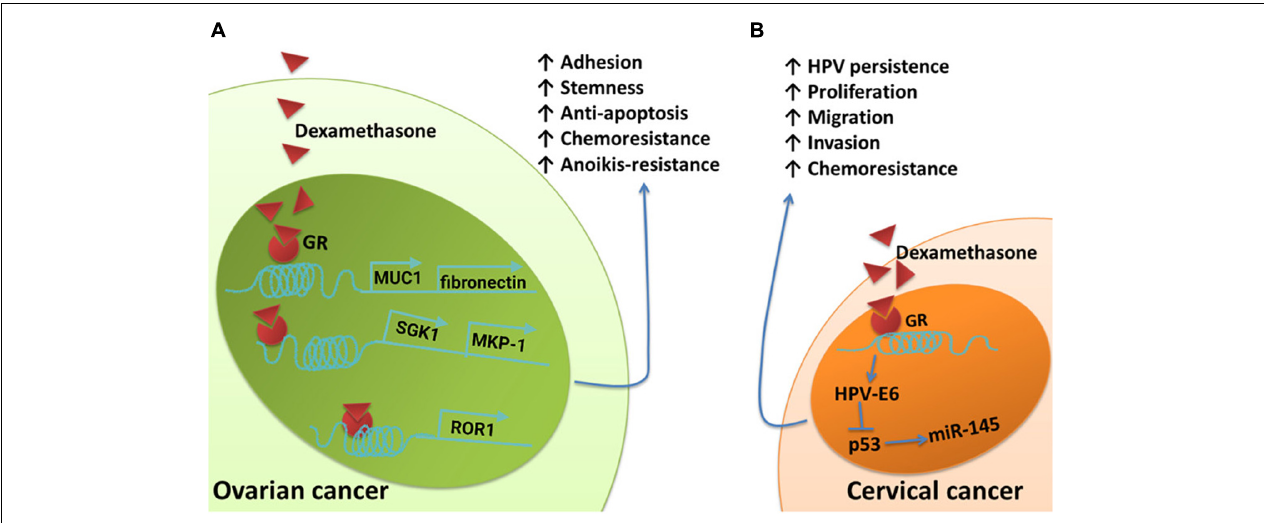
FIGURE 3 | Schematic of the effects of glucocorticoids on pathways involved in cancer cell survival, metastasis, and chemoresistant signaling. (A) The upregulation of fibronectin and MUC1 induced by DEX contributes to DEX-induced pro-adhesion effects and protects ovarian cancer cells from chemotherapy. Dexamethasone induces increased expression of SGK1 and MKP-1, both of which promote cell survival. Dexamethasone induces anti-apoptotic features and drug resistance in ovarian cancer by promoting ROR1-mediated stemness. (B) Glucocorticoid-induced HPV–E6 expression effectively suppresses the upregulation of p53-dependent miR-145 and cellular